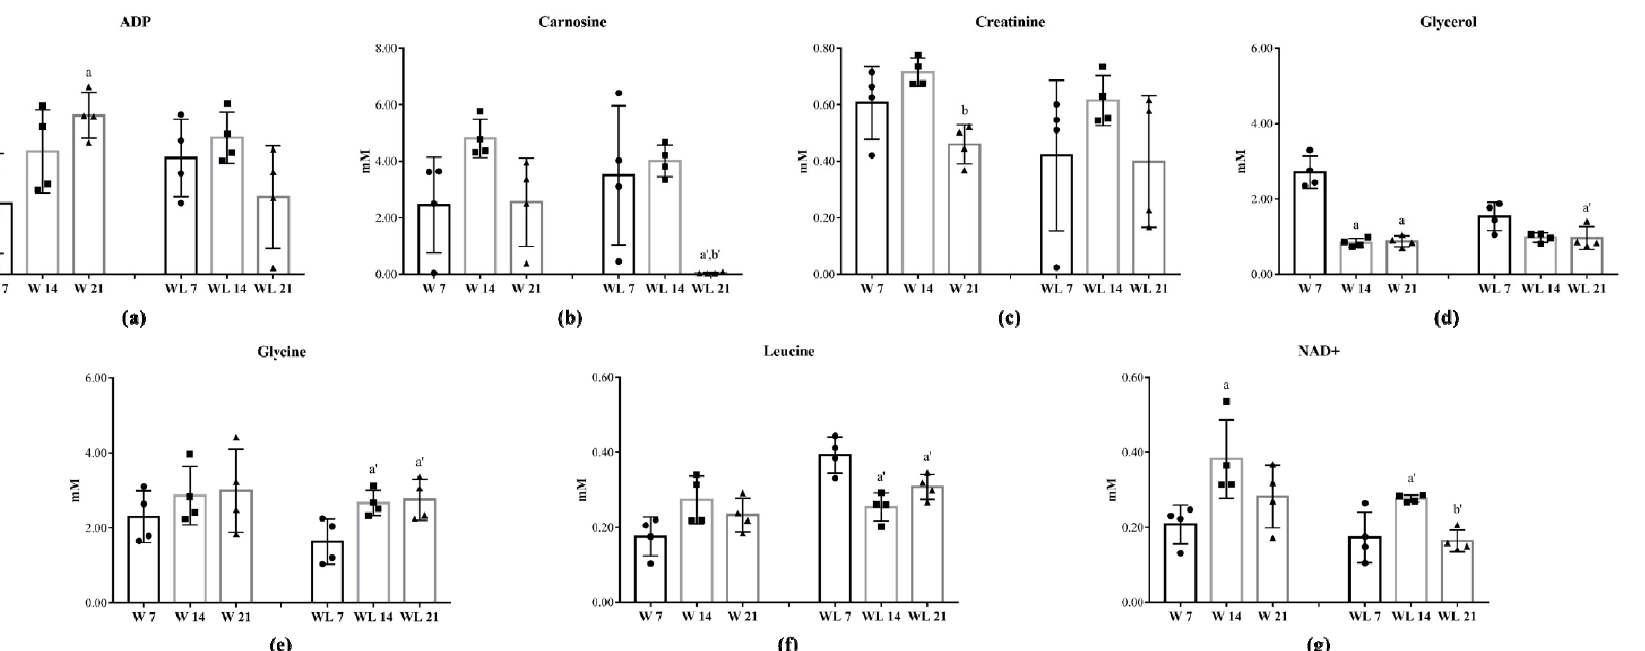
Figure 2. Skeletal muscle metabolic profile identified in rats euthanatised at 7th, 14th and 21st days of the experiment. Concentration of ( a ) ADP; ( b ) Carnosine; ( c ) Creatinine; ( d ) Glycerol; ( e ) Glycine; ( f ) Leucine; ( g ) NAD + . Rats were distributed into Walker tumour-bearing (W7, W14 and W21) and Walker tumour-bearing fed a leucine-rich diet (WL7, WL14 and WL21) euthanatised at 7th, 14th and 21st days of the experiment. Legend: C, control group; W, Walker tumour-bearing group; L, rats fed a leucine-rich diet; WL, tumour-bearing rats fed a leucine-rich diet. Data were expressed as mean ± standard deviation (SD) and analysed by one-way ANOVA followed by Tukey. ( a ) p < 0.05 comparison to W7; ( b ) p < 0.05 comparison to W14; ( a’ ) p < 0.05 comparison to WL7 and ( b’ ) p < 0.05 comparison to WL14.